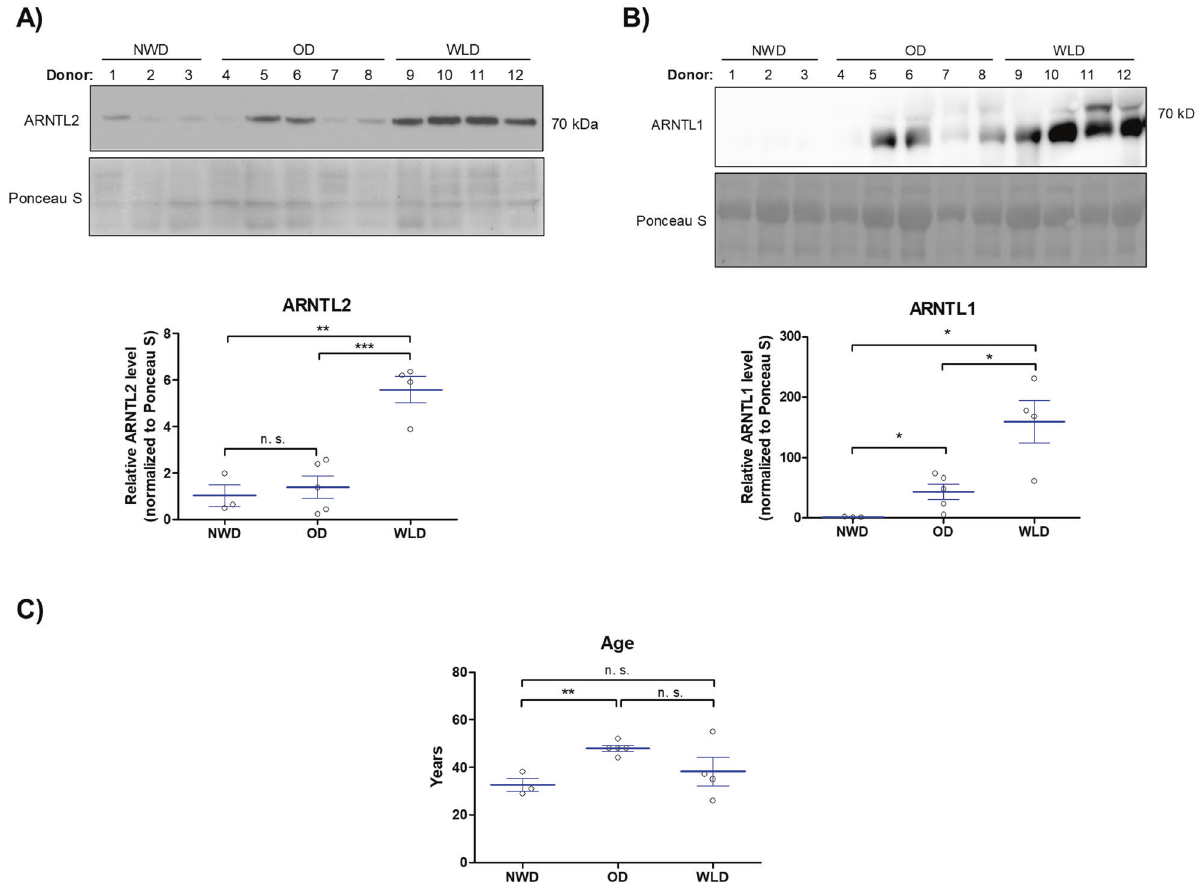
Fig. 8 Western blot analysis of sWAT lysates of NWDs, ODs and WLDs. A ARNTL2 protein levels were detected by Western blot analysis, quanti fi ed and normalized to Ponceau S staining. Statistical comparison was done using the two-tailed unpaired t test. B ARNTL1 protein levels were detected by Western blot analysis, quanti fi ed and normalized to Ponceau S staining. Statistical comparison was done using the two-tailed unpaired t test. C Age of donors corresponding the result presented in ( A ) and ( B ). Statistical comparison was done with the two- tailed unpaired t